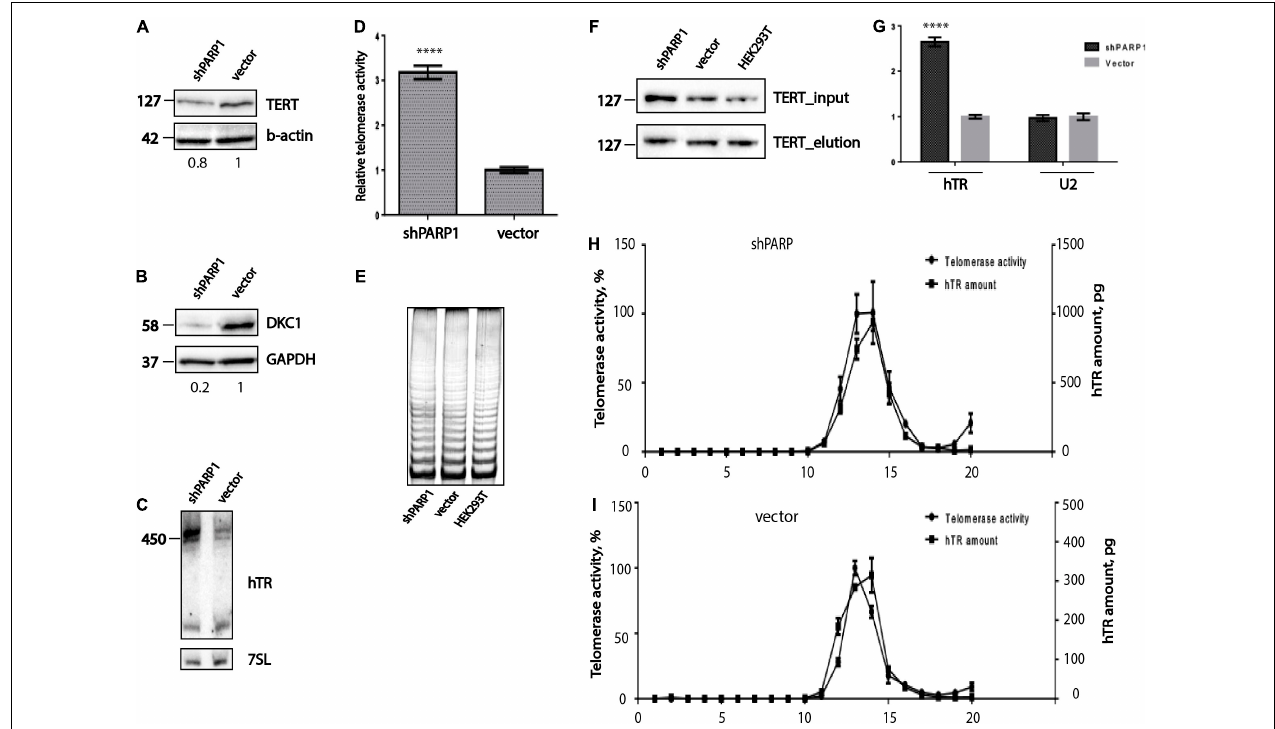
FIGURE 4 | PARP1 is involved in the regulation of telomerase complex composition and stability. (A) Western blot analysis of TERT protein levels in the indicated cell lines. (B) Western blot analysis of DKC1 protein levels in the indicated cell lines. (C) Northern blot analysis of hTR expression in the indicated cell lines. (D) RQ-TRAP telomerase activity analysis in the indicated cell lines. ∗∗∗∗ indicates unpaired t -test two tailed p value < 0,0001. (E) Analysis of telomerase processivity using TRAP assay followed by PAGE separation of PCR products. (F) Immunoprecipitation of hTERT from the indicated cell lines was followed by immunoblotting with anti-hTERT antibodies. (G) RT-qPCR analysis of the amounts of hTR co-immunoprecipitated with hTERT. U2 RNA was used as a control. ∗∗∗∗ indicates unpaired t -test two tailed p value < 0,0001. (H) Analysis of hTR distribution and telomerase activity after separation of extracts from HEK293T cells expressing a shRNA targeting PARP1 mRNA, using a sucrose gradient. (I) Analysis of hTR distribution and telomerase activity after separation of extract from HEK293T cells expressing the empty LeGo-Cer vector, using a sucrose